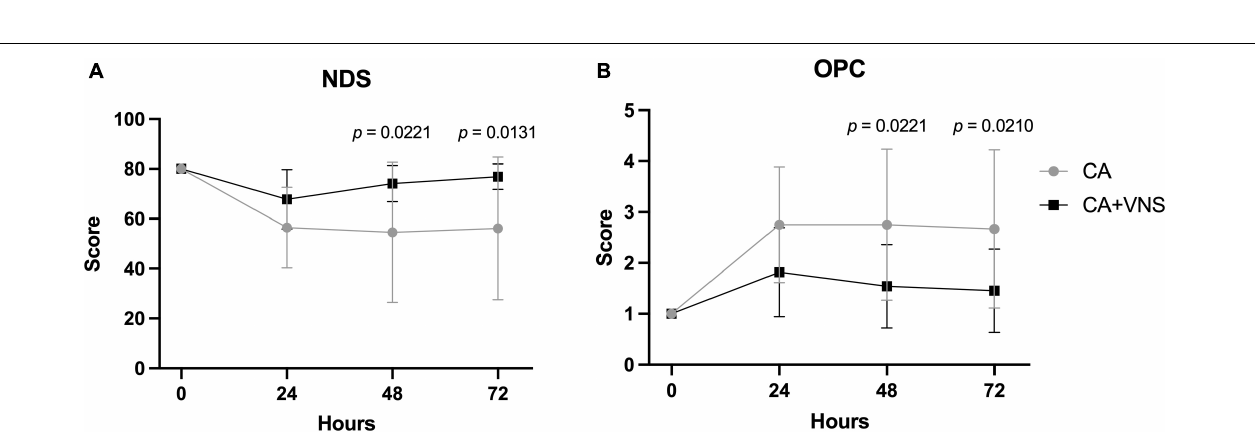
FIGURE 3 | Comparisons of neurological outcomes at 0, 24, 48, and 72 h after ROSC. (A) NDS in the CA ( n = 12) and CA + VNS ( n = 11) groups at 0, 24, 48, and 72 h after ROSC. p < 0.0001 between times, p = 0.0300 between groups, p = 0.0087 between times × groups; two-way RM ANOVA. (B) OPC (OPC; 1, normal; 2, slight disability; 3, severe disability; 4, comatose; 5, dead) in the CA ( n = 12) and CA + VNS ( n = 11) groups at 0, 24, 48, and 72 h after ROSC. p < 0.0001 between times, p = 0.0271 between groups, p = 0.0064 between times × groups; two-way RM ANOVA. Data are presented as the mean ± standard deviation. Only p -values < 0.05 are depicted in the graph and indicate the statistical comparisons of both groups at the marked time (Bonferroni’s post hoc multiple comparisons test). NDS, neurologic deficit score; OPC, overall performance category; ROSC, return of spontaneous circulation; VNS, vagal nerve stimulation; CA, cardiac arrest.